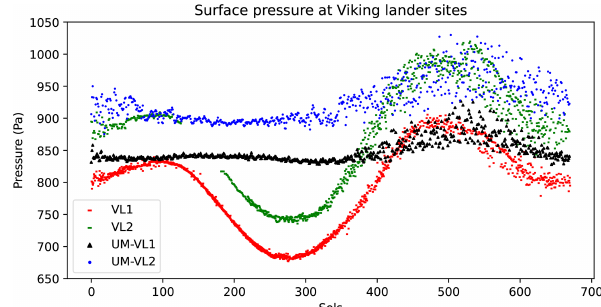
Figure 5. UM surface pressure at approximate Viking lander 1 and Viking lander 2 sites compared to observational data across a Mar- tian year. Viking lander data available from Tillman